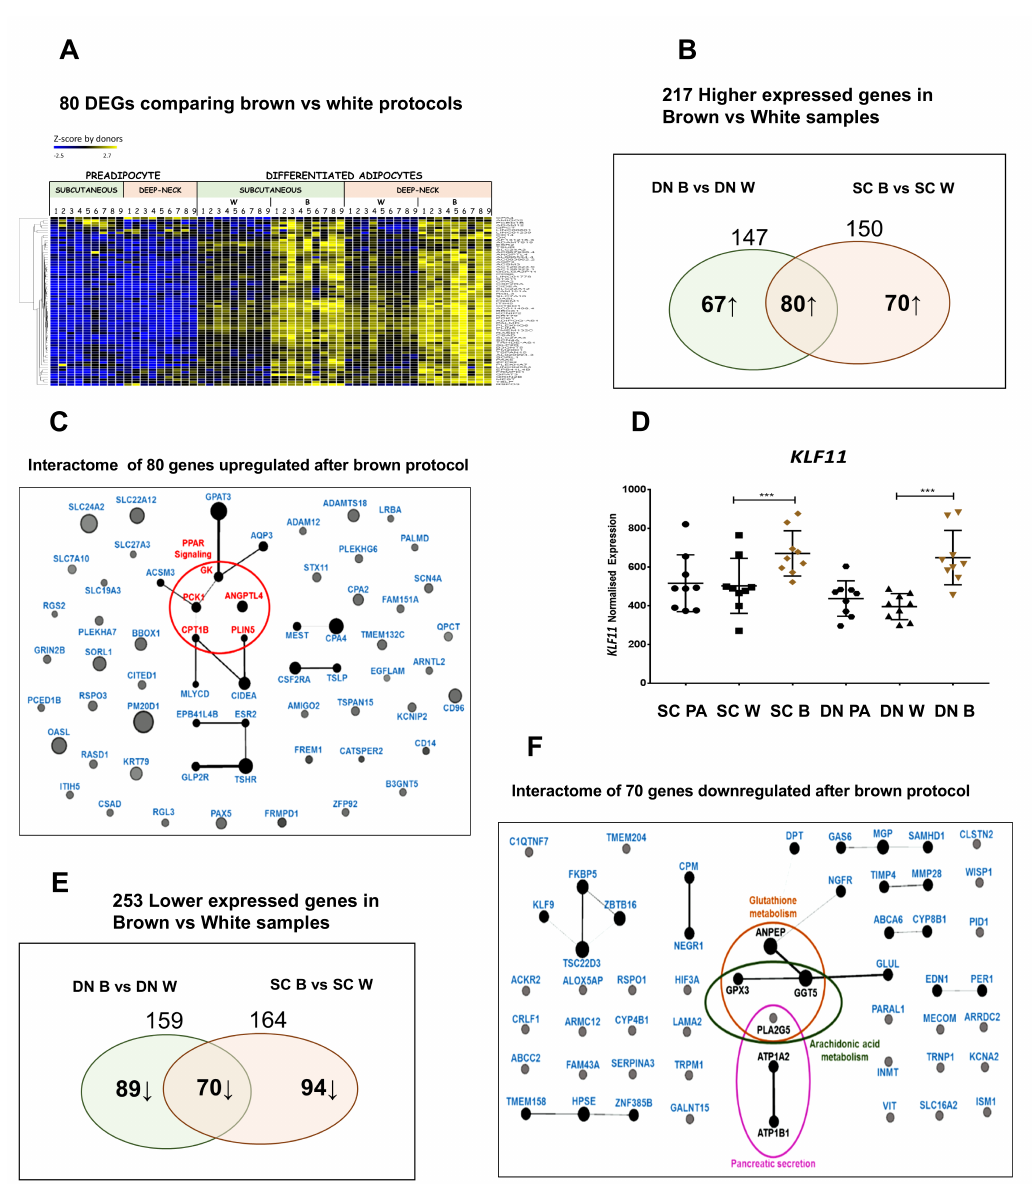
Figure 5. Expression of genes up- and downregulated after browning protocol in both subcutaneous (SC) and deep-neck (DN) adipocytes. ( A ) Heat map of the upregulated genes. 1 to 9 labels the individual from which the sample was obtained. ( B , E ) Venn diagrams of the number of genes responding to brown di ff erentiation. ( C , F ) Representation of overlapping up- and downregulated genes, respectively, in a Gephi interactome map where the size of circles is proportional to the fold change in expression values. ( D ) Expression profile of KLF11 based on DESeq normalized RNAseq data, statistics: GLM *** p < 0.001. PA: preadipocytes, W: white di ff erentiation protocol, B: brown di ff erentiation